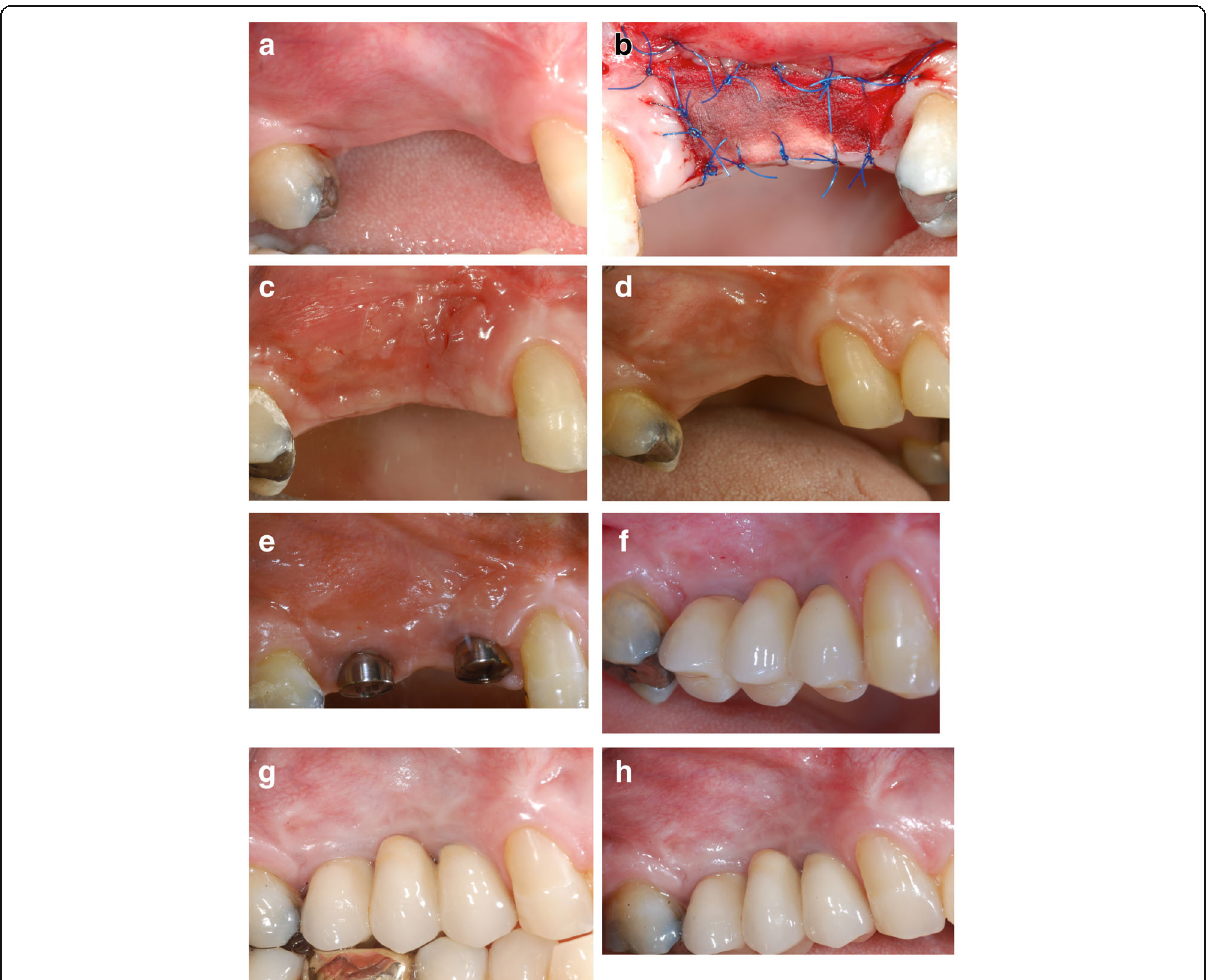
Fig. 1 a Pre-op. b Post-op. c Two weeks after surgery. d Four weeks after surgery. e Six months after surgery. f One year after surgery. g Four years after surgery. h Five years after